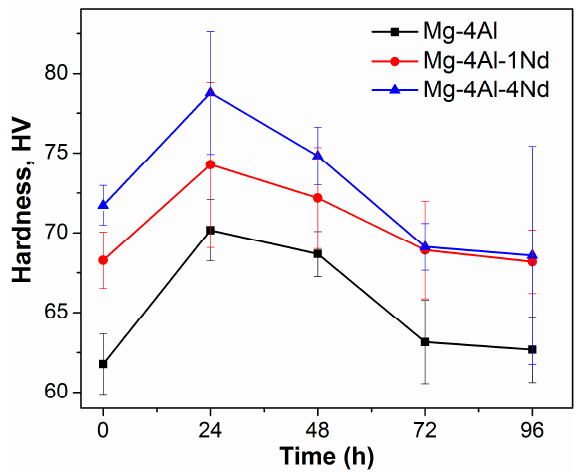
Figure 7. Vickers micro hardness of heat-treated alloys.